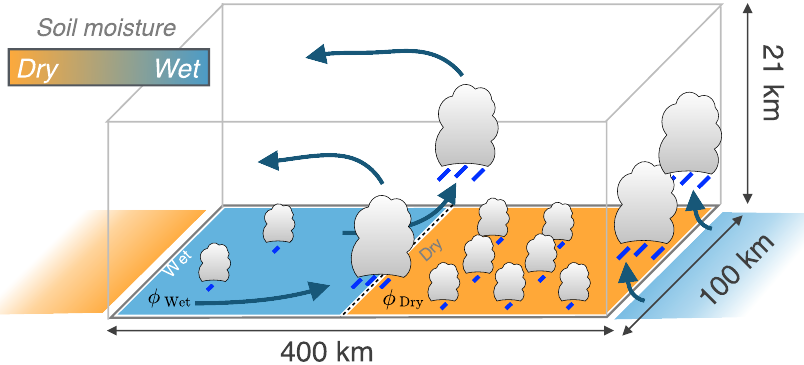
Figure 1. Idealized sketch of the employed experimental framework. The initial condition for soil moisture and the expected initial develop- ment of convection are also sketched in order to ease the interpretation of the